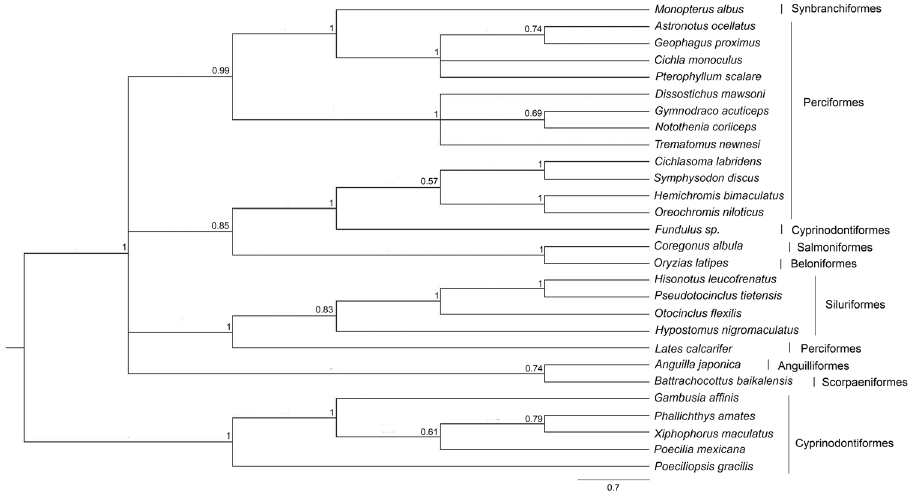
Figure 6. Phylogenetic placements of partial nucleotide sequences of Rex1 from 28 teleosts. Support values at each node are Bayesian posterior probability.